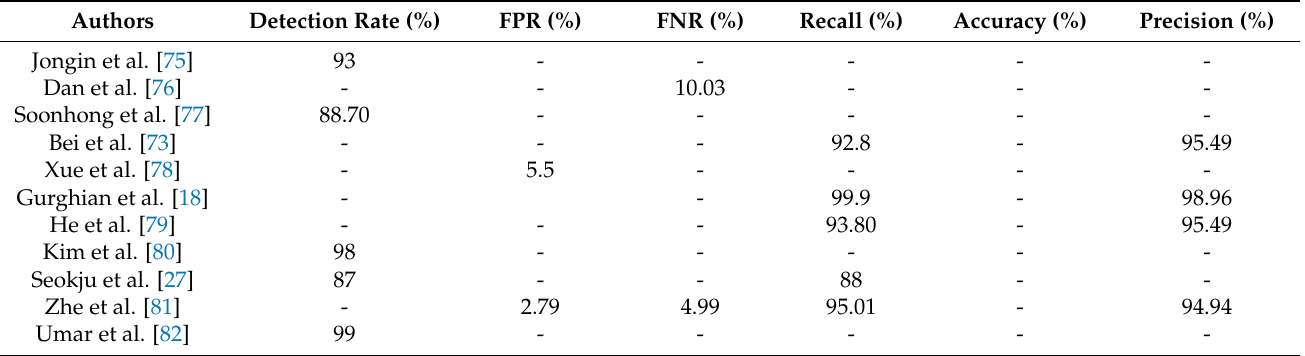
Table 2. Summary of the performances among various deep learning